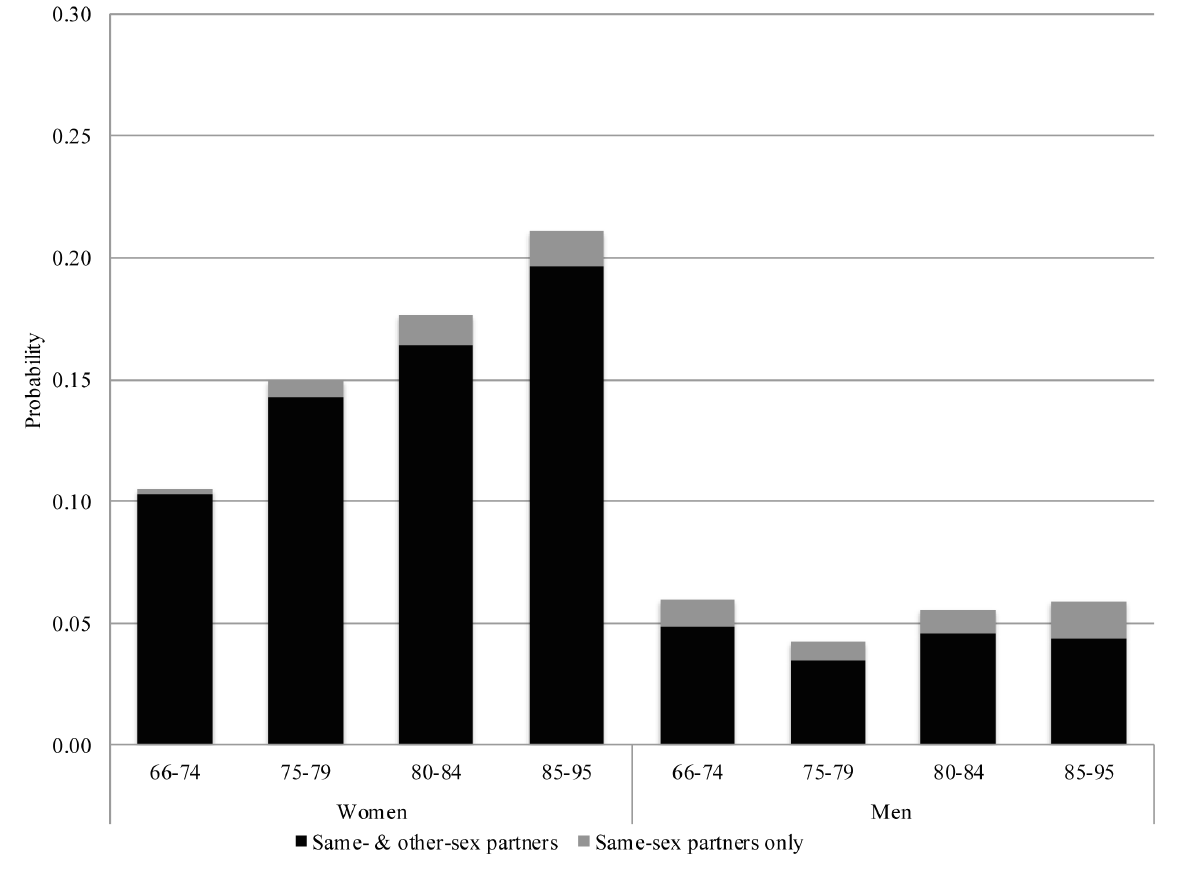
Figure 1: Women’s and men’s predicted probability of having had sex with same-and other-sex partners, by birth